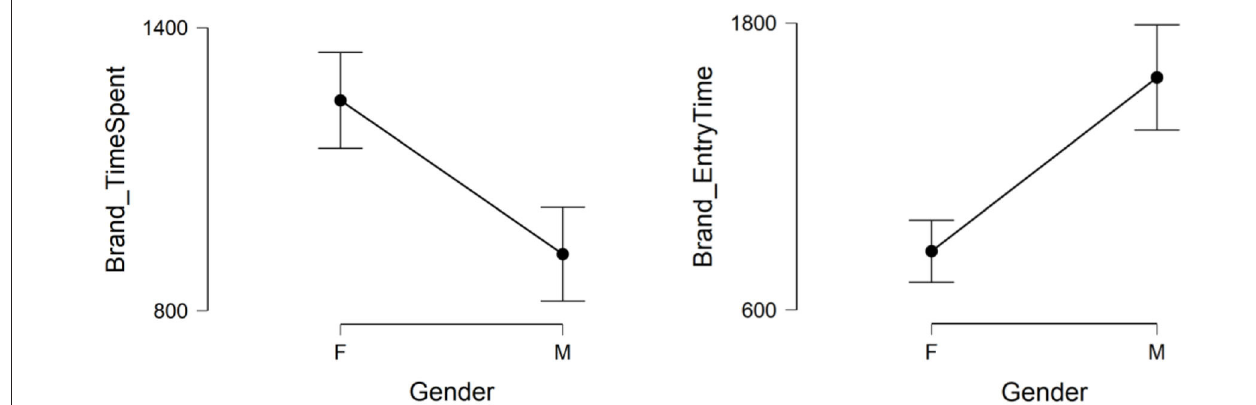
FIGURE 3 | Plot 3 – brand time spent, brand entry time/gender relation.